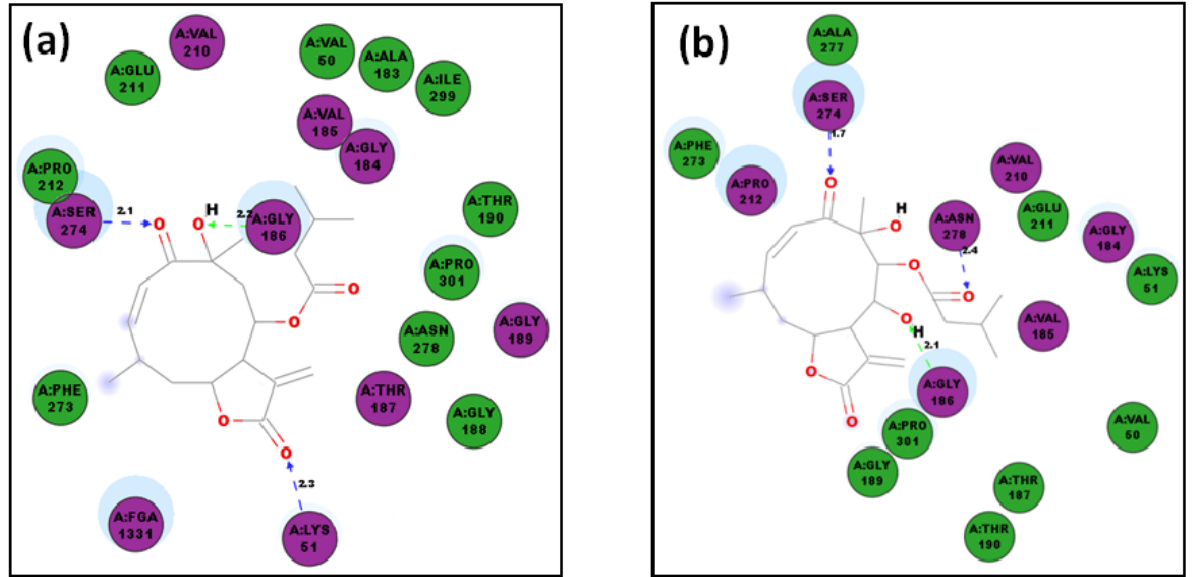
Interactions are represented as: van der Waals (green circle); polar (magenta circle); H -bond with amino acid side chains (blue dashed line); H -bond with amino acid backbone (green dashed line); pi interaction (orange line). Figure 14. ( a ) Lowest-energy docked pose of agarofuran 22 with Ld NMT; ( b ) 2D representation of protein ligand interactions of compound 22 with Ld NMT.